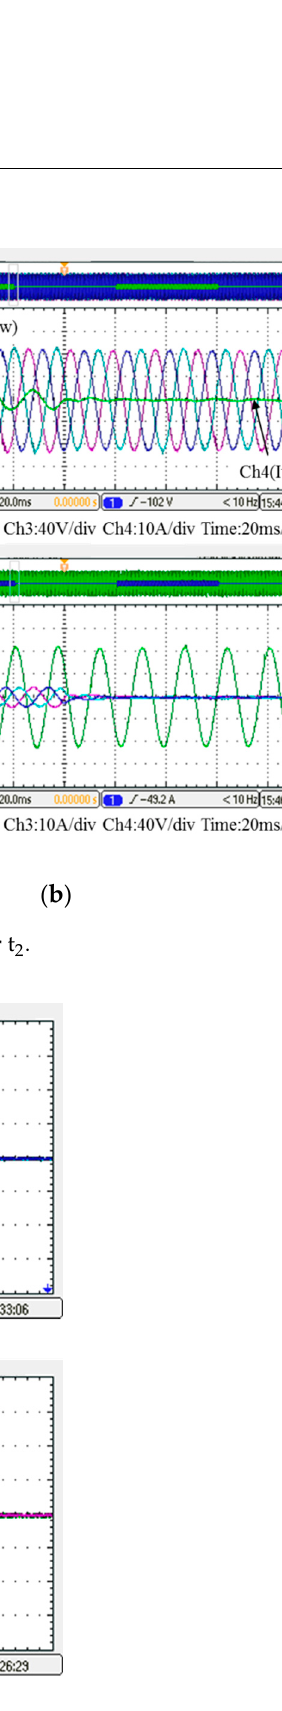
Figure 27. Case 1 implementation result: feedbacks and commands of reactive power and inductor current (all control signals are in V).